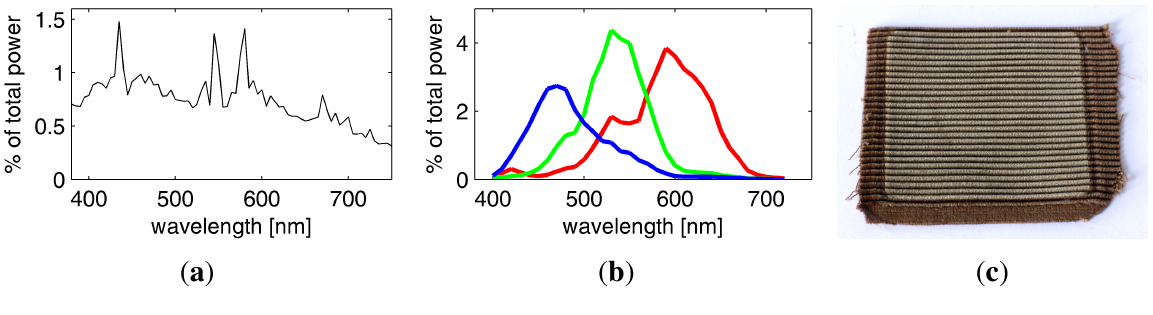
Figure 6. Spectral power distribution of the employed HMI bulb (a) and sensitivity of the DSLR camera (Kodak DCS Pro 14n) (b). The red, green and blue curves correspond to the respective primaries in the Bayer pattern. (c) shows the damage caused prior to installing a UV filter in front of the lamp: The uncovered area of the material sample is bleached due to prolonged UV exposure during measurement. ( a ) HMI bulb; ( b ) DSLR Camera; ( c ) UV